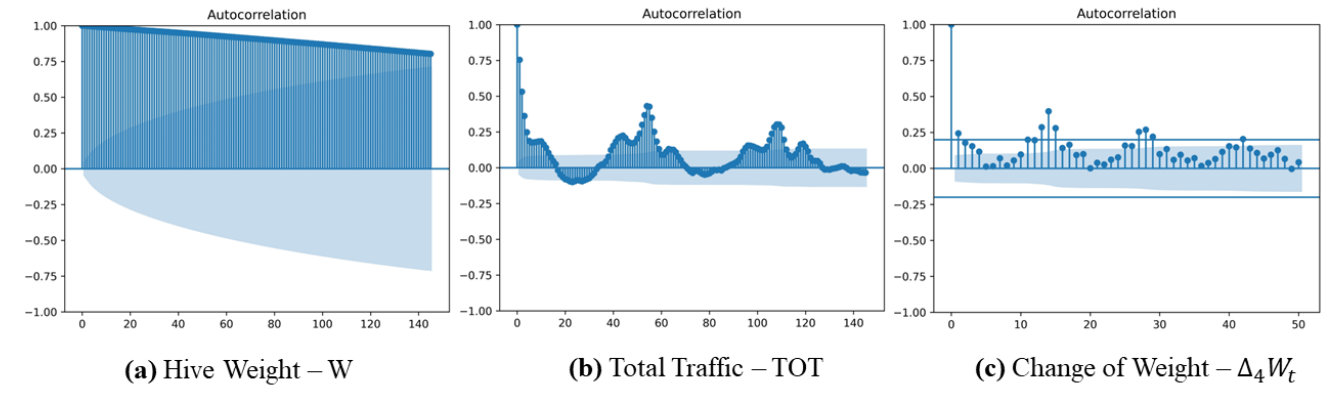
Figure 2. Autocorrelation plots of weight ( a ), total traffic (TOT) ( b ), and change in weight over 1 h ( c ) for hive H17 given using a standard python method statsmodels.graphics.tsaplots ; the lags for ( a , b ) change from 0 to 145, where value 145 approximately equals 2.5 periods as 54 is the full number of records per day; the lag for ( c ) runs from 0 to 50 ( ≈ 3.5 periods) with a period of 12 (i.e., the number of data points per day for k = 4); semi-transparent solid blue regions represent confidence intervals for ACF